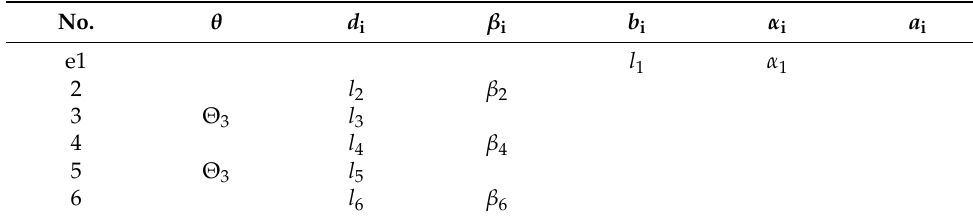
Table 2. Joint parameters of the upper limb exoskeleton. No. θ